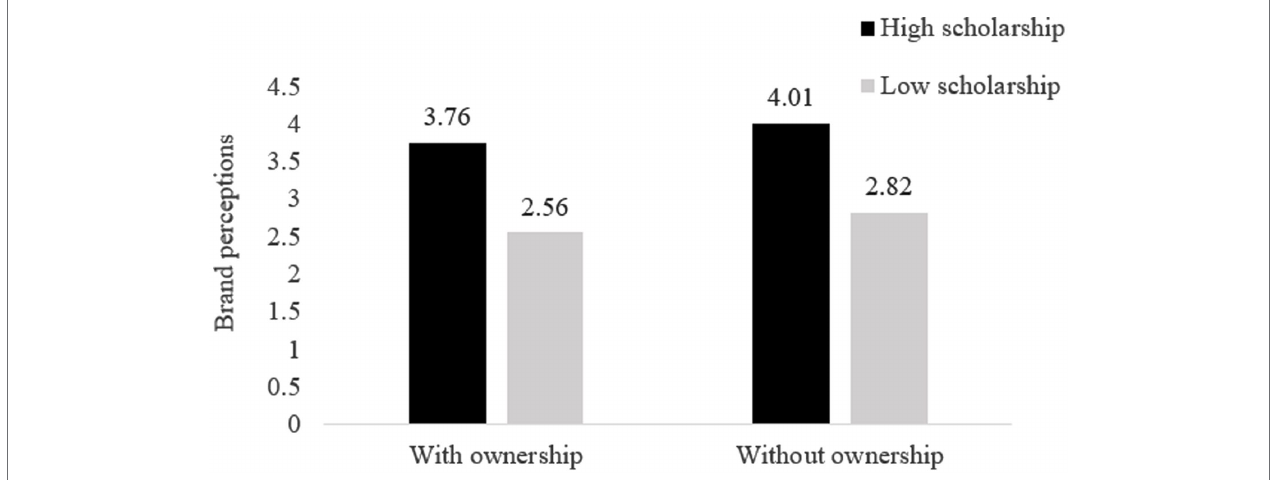
FIGURE 1 | The effect of scholarship policies and ownership levels on brand perceptions (Study